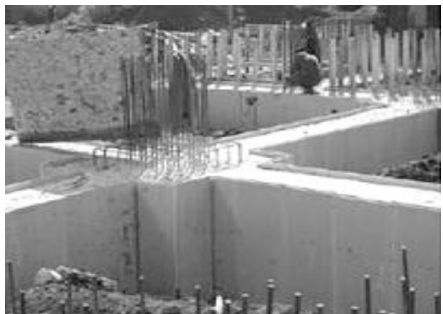
Fig. 4. The remote control shutters.